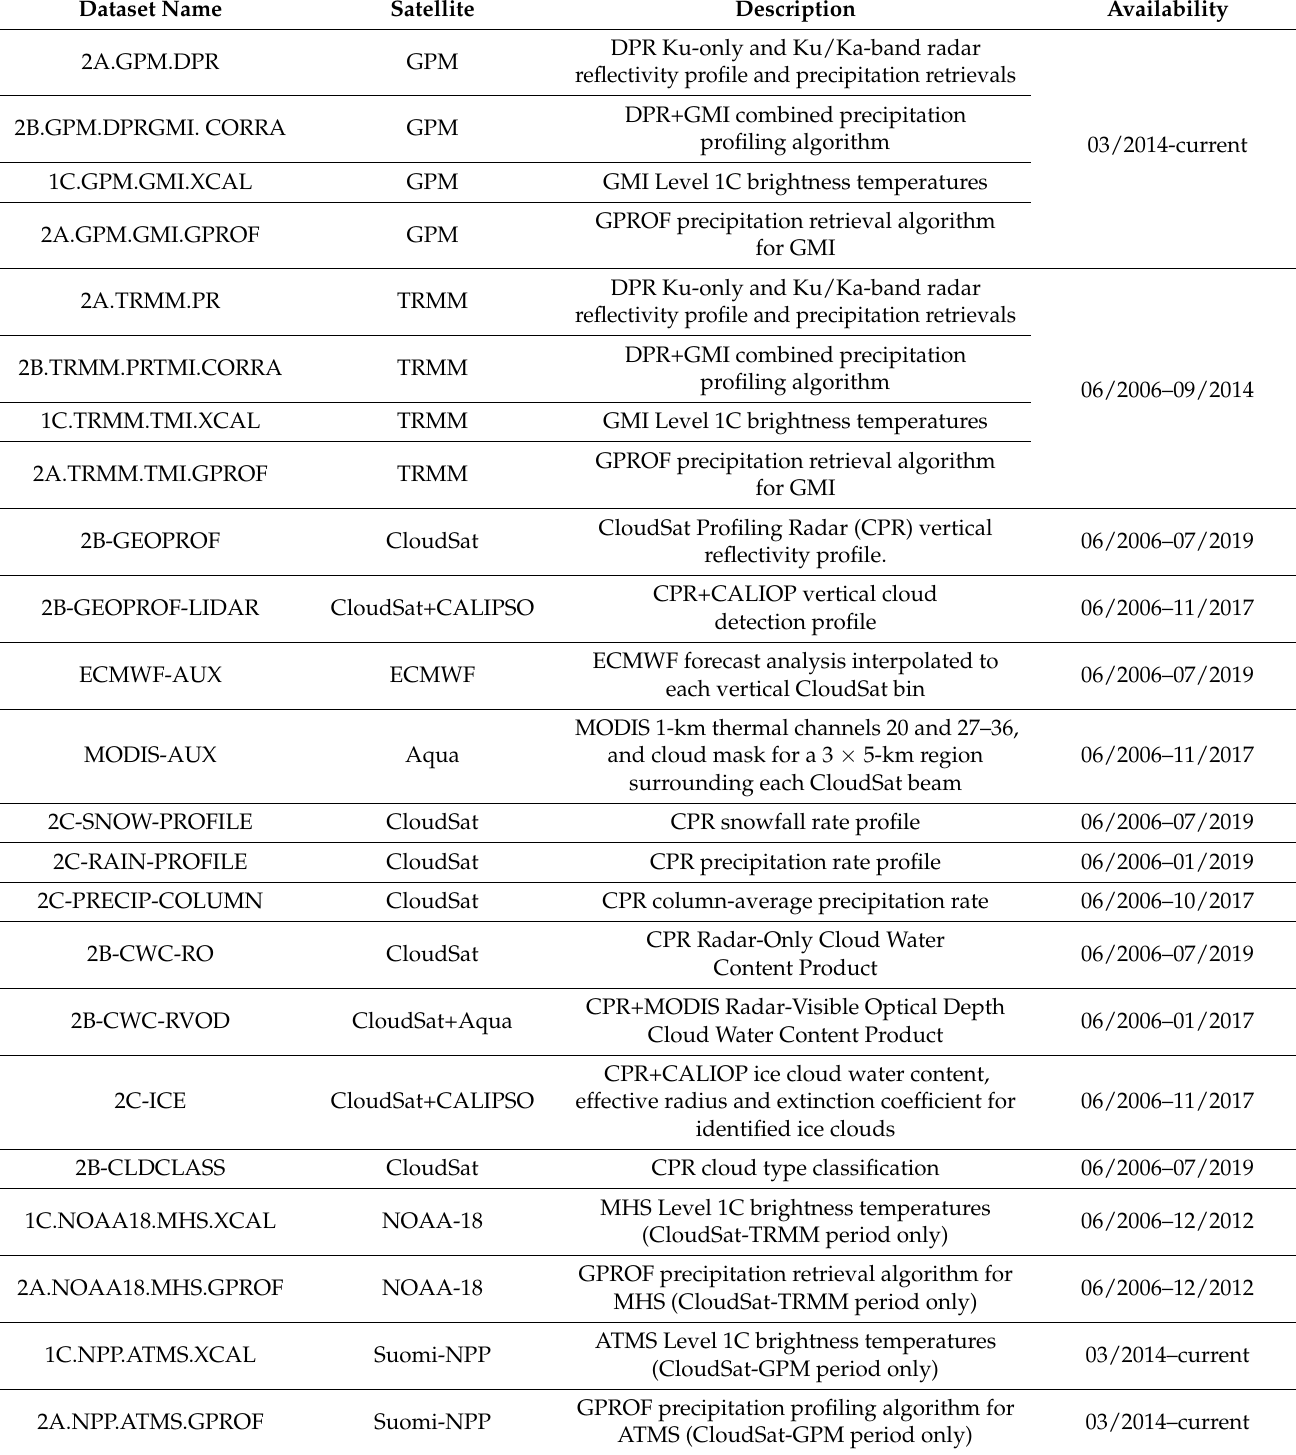
Table A1. Datasets used for creating the CloudSat-TRMM and CloudSat-GPM coincidence datasets, and their availability since June 2006 to current (April 2021). Currently, CloudSat-GPM coincidence data are only processed through September 2016. Datasets obtained via the Precipitation Processing System (PPS) are indicated in bold font; others are obtained from the CloudSat Data Processing Center